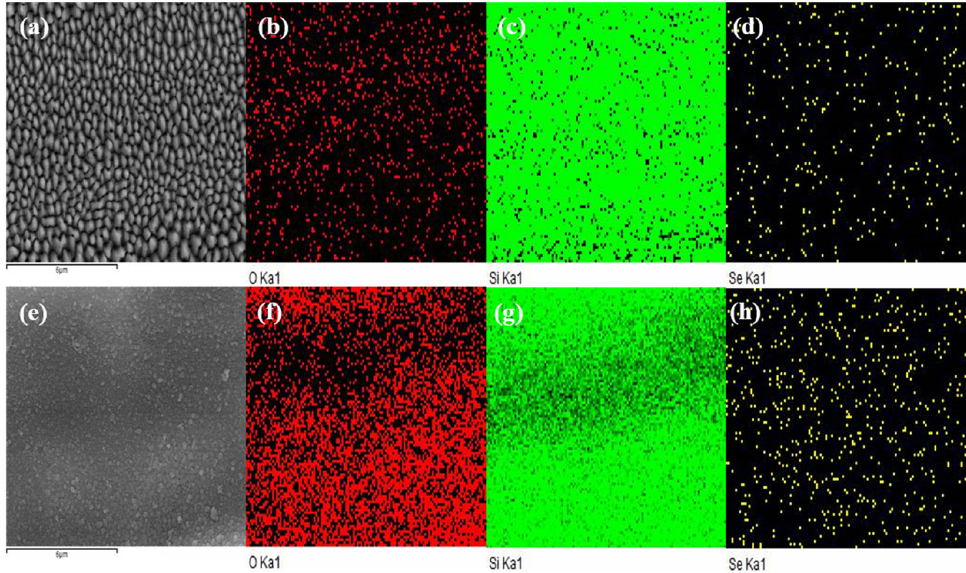
Figure 5. EFSEM maps of oxygen, silicon, and selenium for ( a – d ) fs ‐ laser ‐ treated Si and ( e – h ) ps ‐ laser ‐ treated Si.